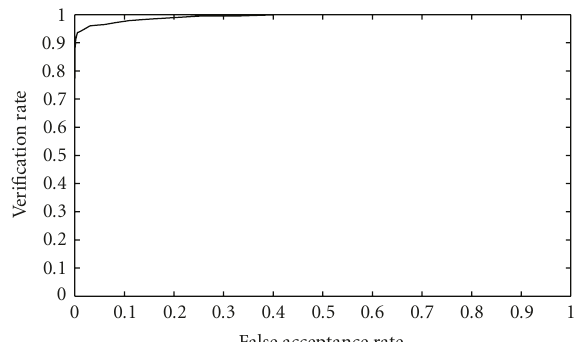
Figure 21: Receiver operating curve for the database captured with the Axis 233D Network PTZ camera. The verification rate obtained at a false accept rate of 1% (1 image out of 84) is 95% (79 images out of 84). The number of classes used in this experiment is 12, with 7 images per class.